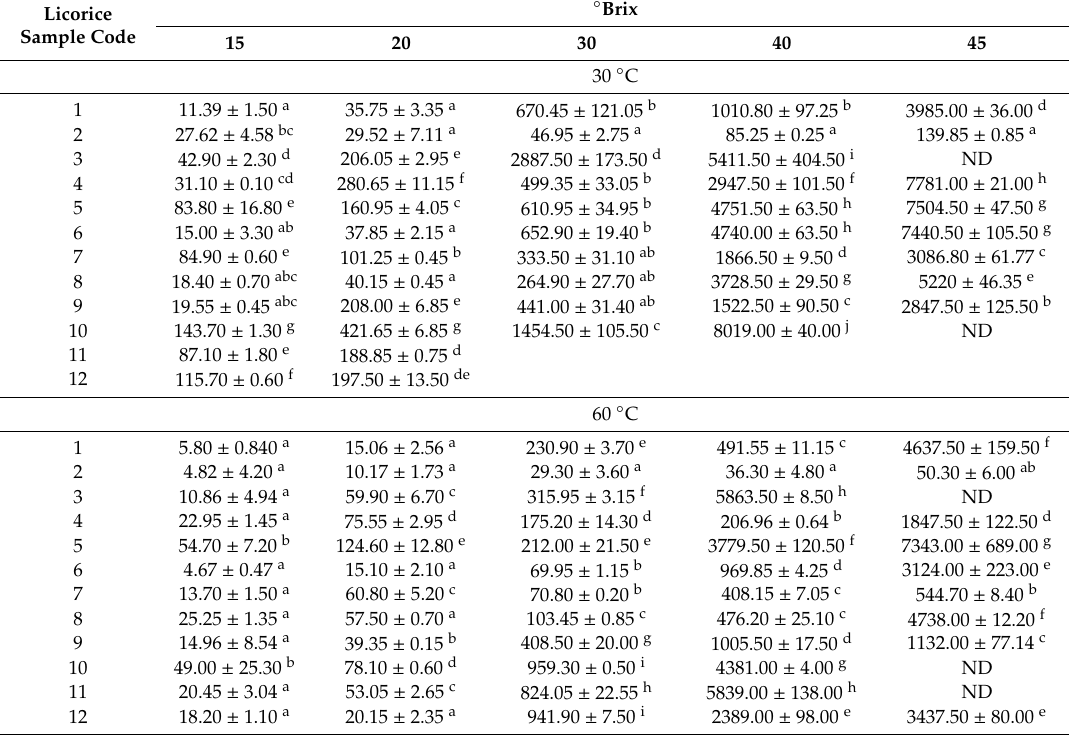
Table 2. The consistency coe ffi cient, k, (mPa · s) of twelve licorice extract samples harvested at various seasons and produced using the same commercial licorice processing line as a function of degrees Brix at 30 and 60 ◦